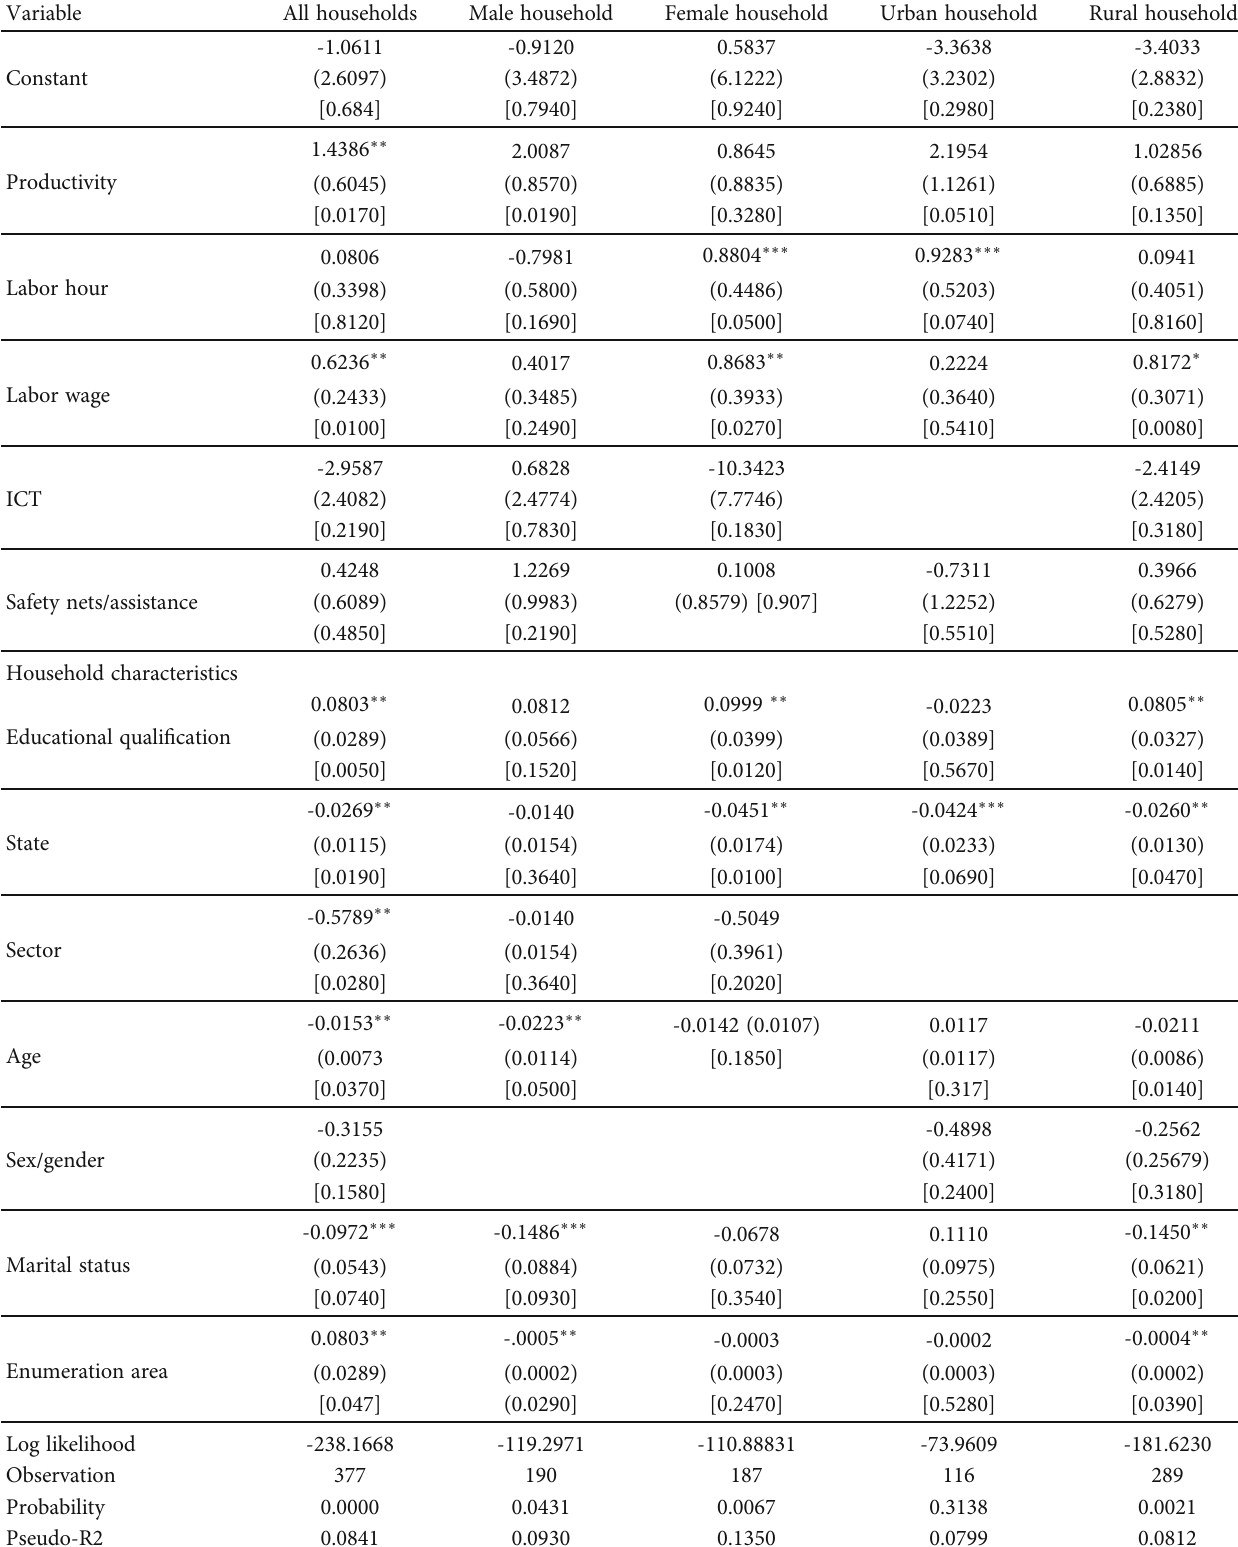
Table 5: Robustness estimates (outcome variable: food